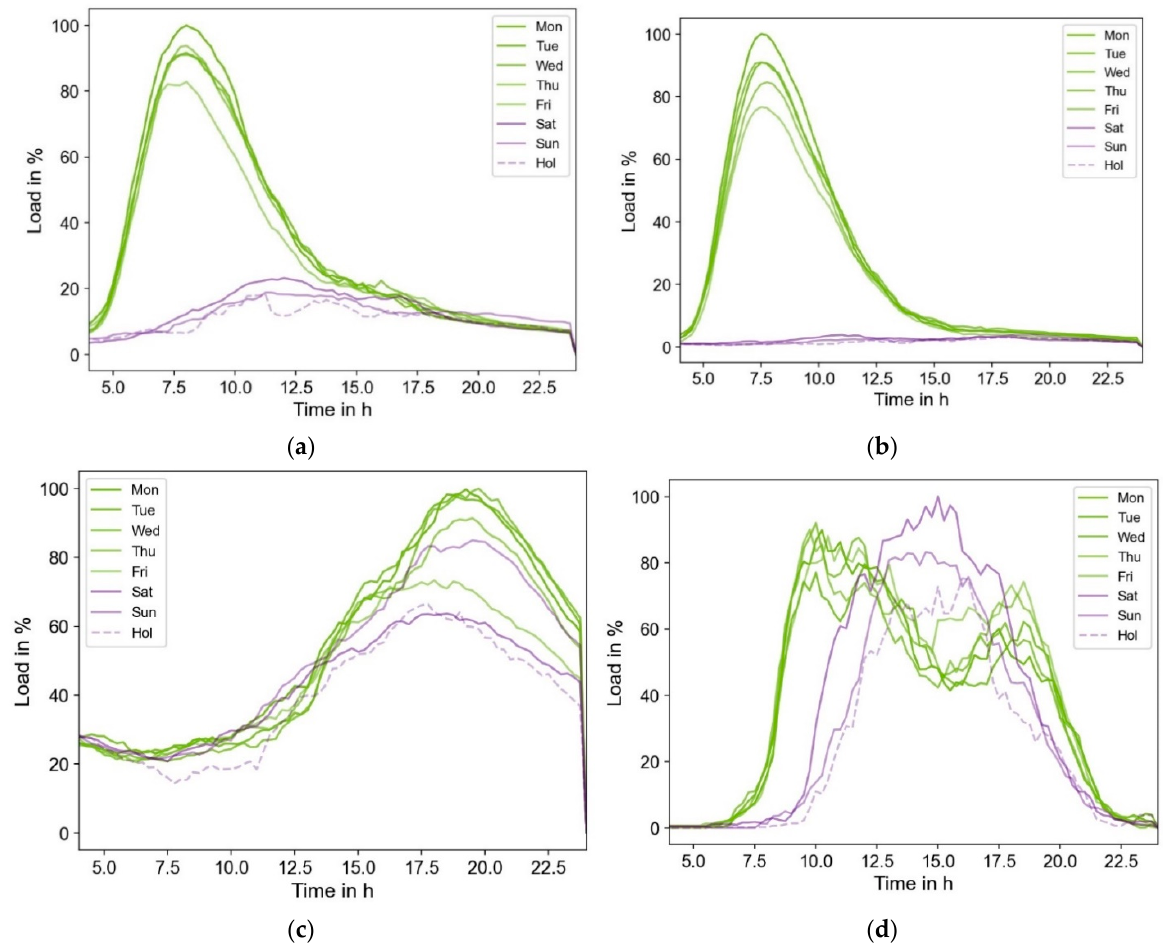
Figure 1. Aggregated daily load curves of the categories of charging sites. The weekdays from Monday to Friday are in green, and weekends and public holidays are in purple: ( a ) Car park; ( b ) Office; ( c ) Residential; ( d ) Shopping center.